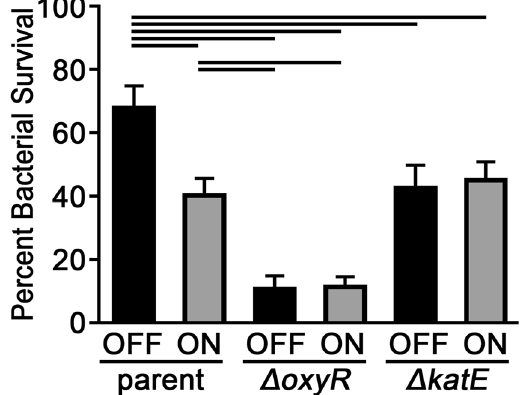
Figure 3. ModA2-mediated regulation of H 2 O 2 resistance is independent of OxyR. Mutants that lacked oxyR , had significantly decreased survival when exposed to H 2 O 2 stress compared to either parent. In contrast to the parents, there was no significant difference in survival between the oxyR mutants themselves. There was no significant difference between the survival of the Δ katA modA2 locked ON and the Δ katA modA2 locked OFF mutants, and the survival of both Δ katA mutants was similar to that of the modA2 locked ON parent. Statistical differences were determined by 1-way ANOVA with Tukey’s multiple comparisons; lines above bars indicate significance, Alpha = 0.05.